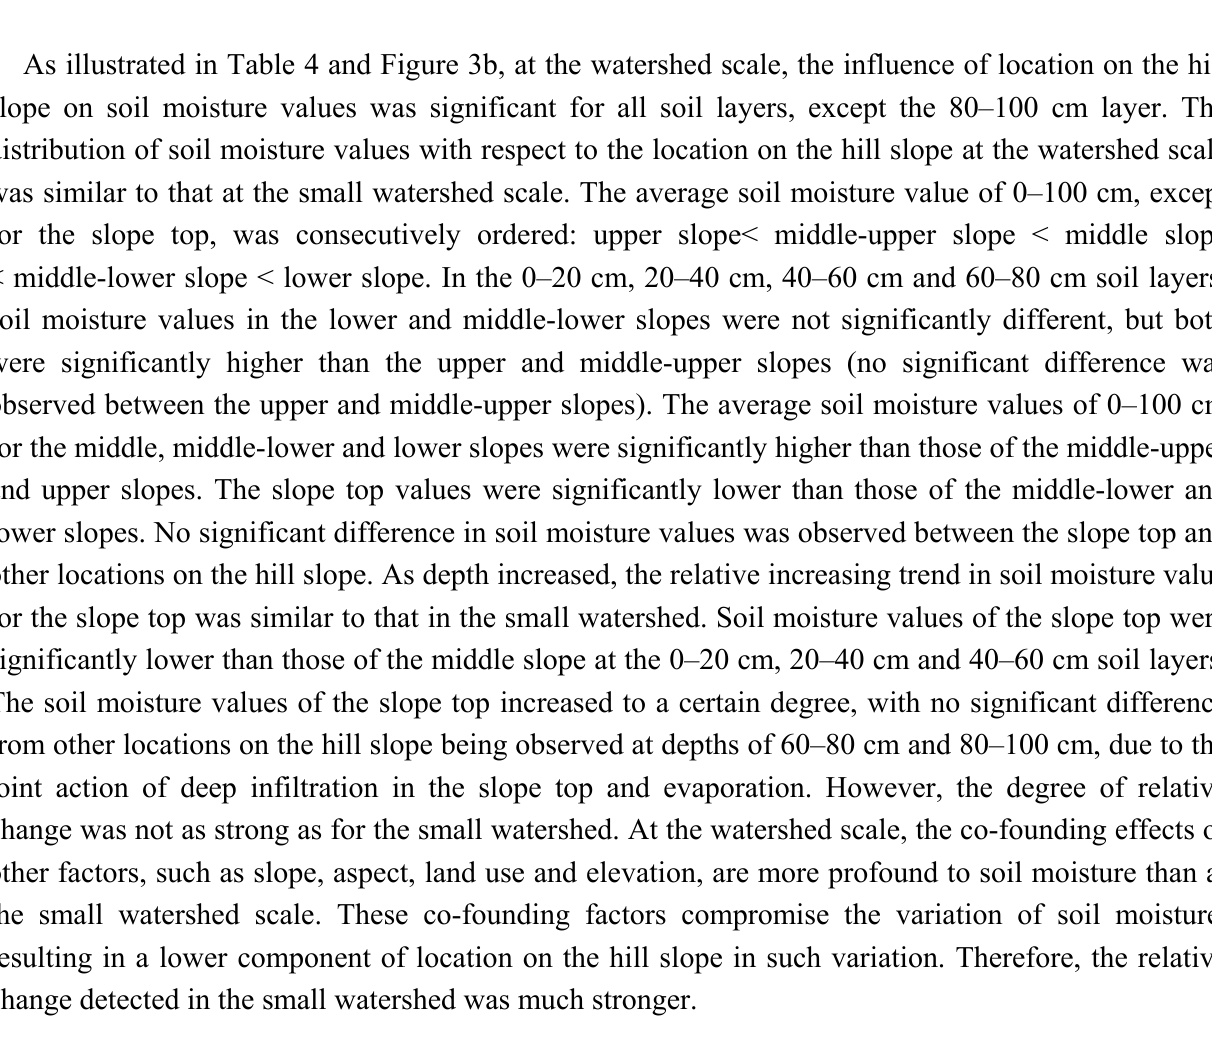
Table 4. One-way ANOVA for the effects of location on the hill slope on soil moisture